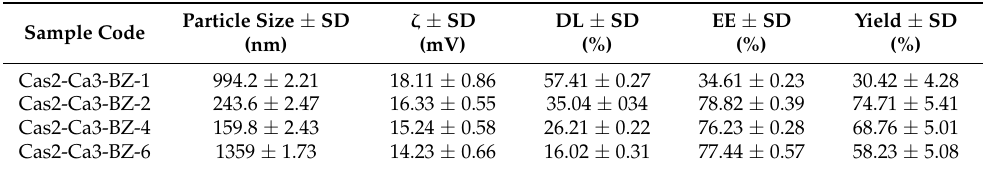
Table 3. Characteristics of the spray dried BZ-loaded casein nanoparticles (n = 3). DL = drug loading, EE = entrapment